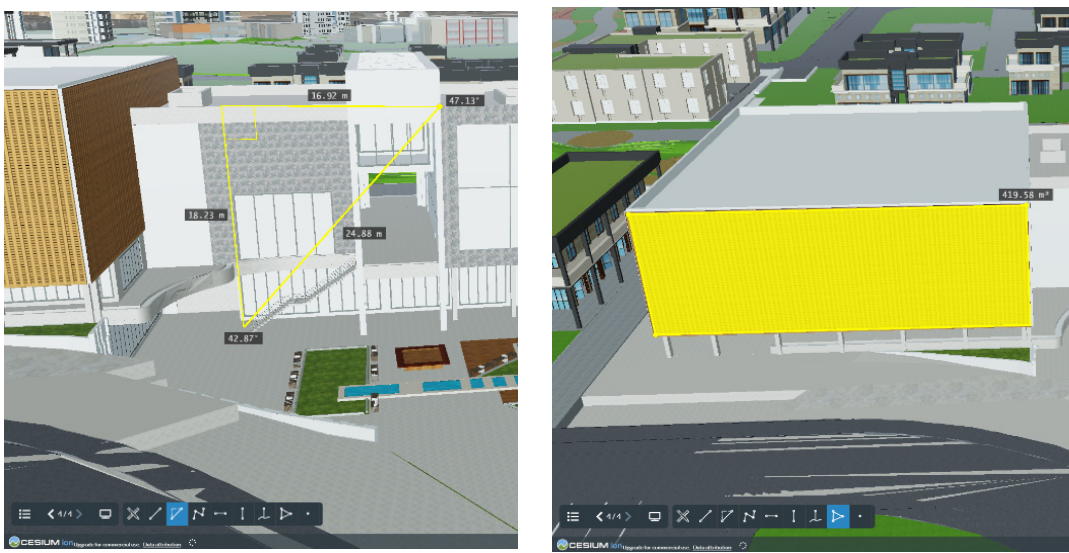
Figure 20. Component distance ( left ) and area measurement tool ( right ) on the developed web interface.